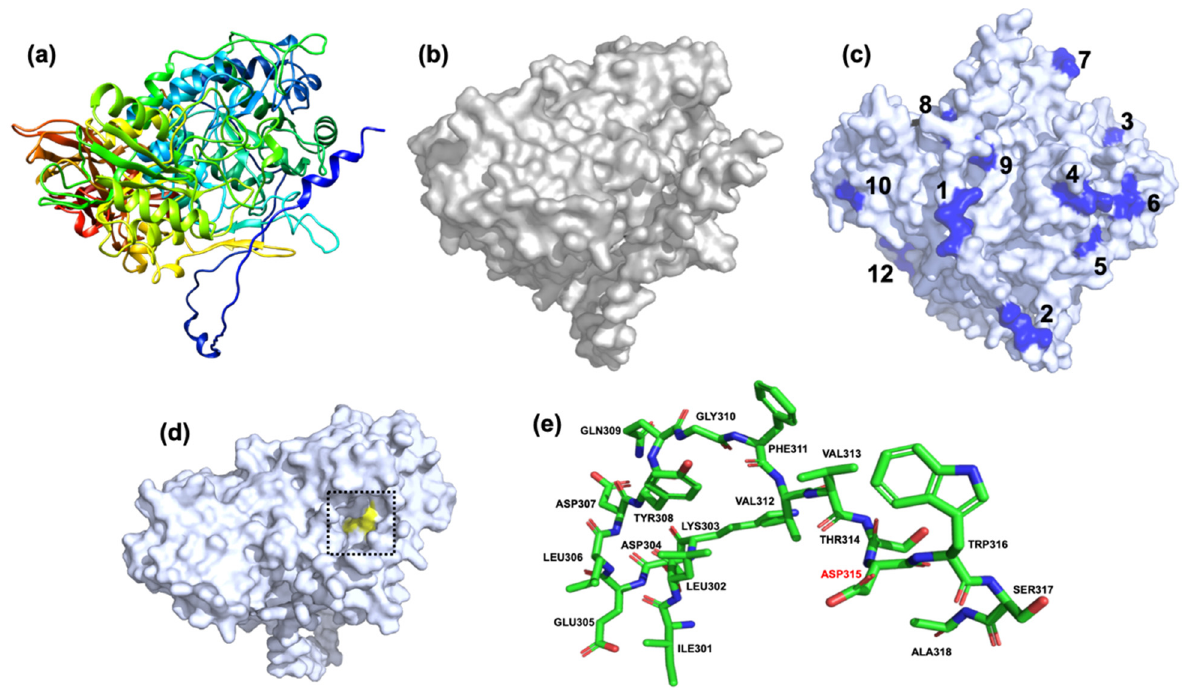
Figure 5. Structural modeling of the β -xylosidase SRBX1 protein from S. reilianum. ( a , b ) Three-dimensional structures. ( c ) Location of the glycosylation sites. The protein has 12 possible glycosylation sites. Except for site number 11, all others are located on the protein’s surface (indicated in blue). ( d ) The location of the active site is in yellow in the dashed box. ( e ) Amino acids of the active site. ASP315, which theoretically participates in enzymatic catalysis, is shown in the letters red. The structural modeling was performed using the bioinformatic web-server AlphaFold Colab (https://colab.research.google.com/github/deepmind/alphafold/blob/main/notebooks/AlphaFold.ipynb#scrollTo=XUo6foMQxwS2, accessed on 5 November 2022).